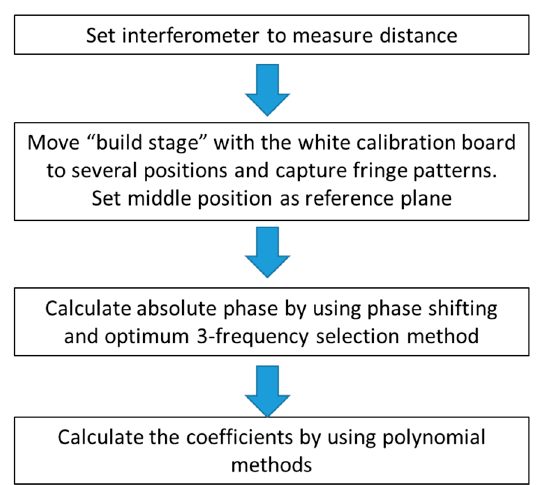
Figure 6. The procedure for the depth calibration.